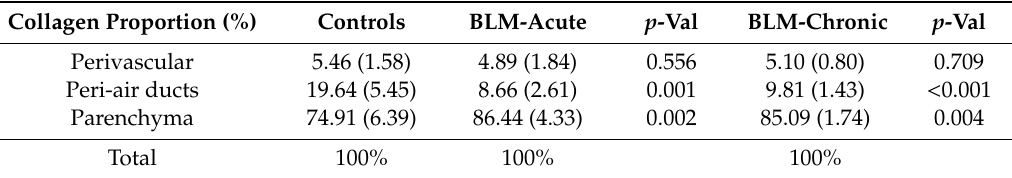
Table 3. Lung collagen proportion per ROI. Mean percentages ( ±